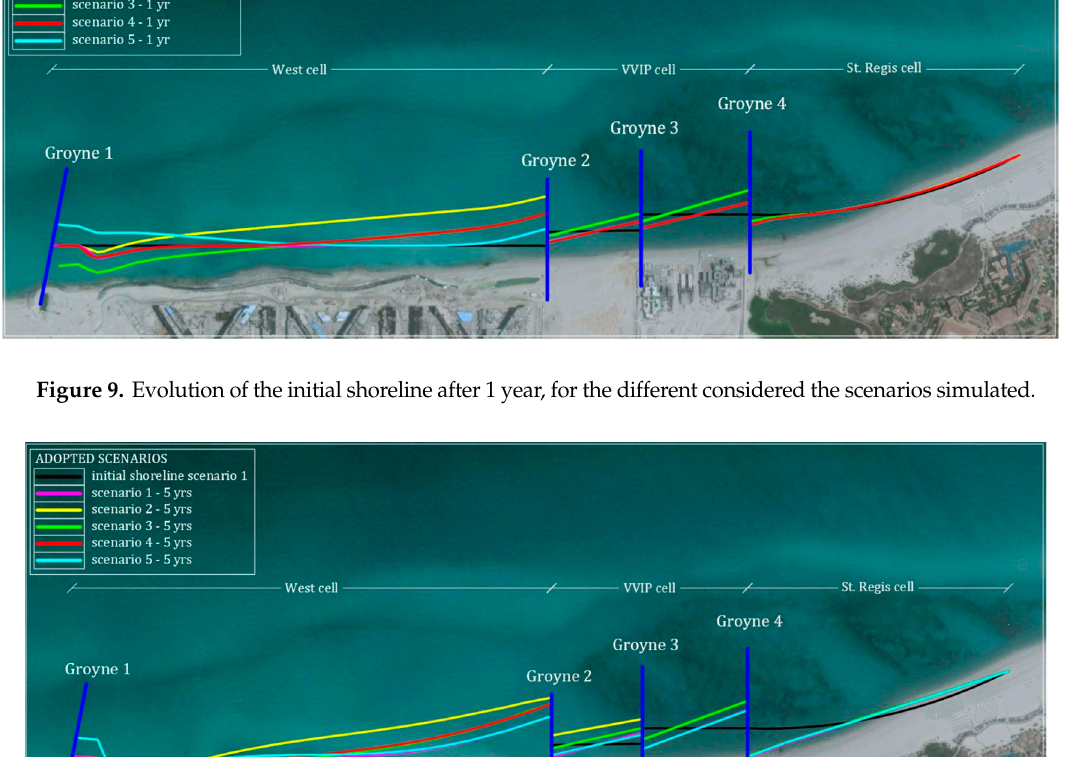
Table 4. Maximum accretion/erosion occurred after 1 year, for the proposed scenarios.